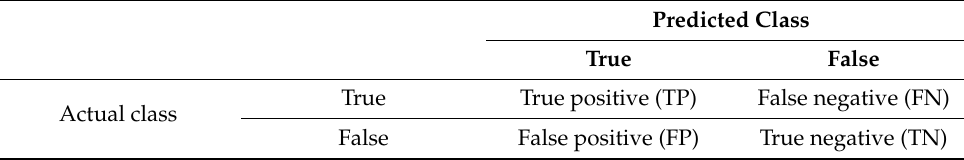
Table 4. Confusion